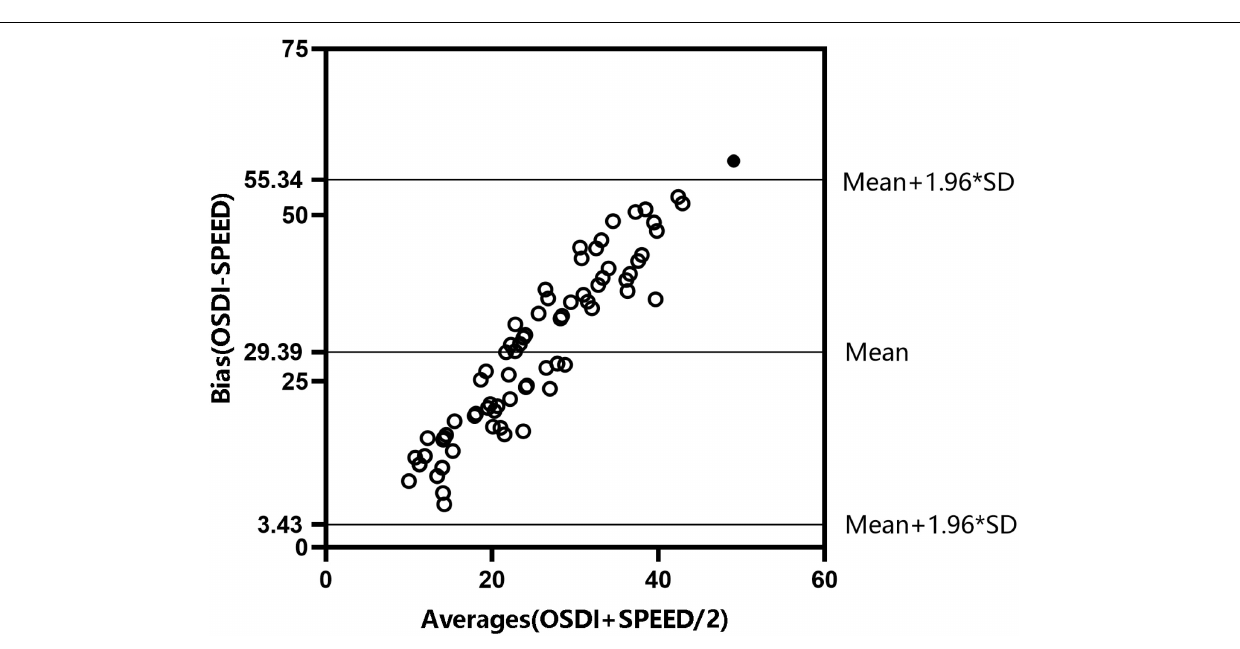
results show a statistically significant difference, except for IOP ( p >